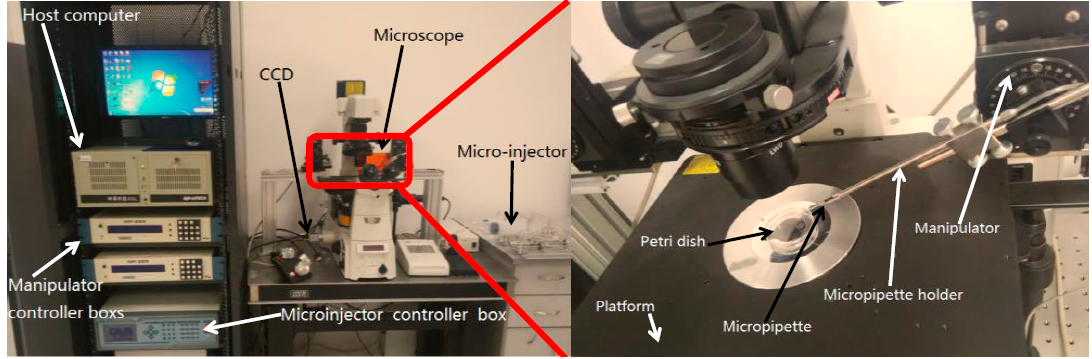
Figure 3. The NK-MR701 micro-operational system.